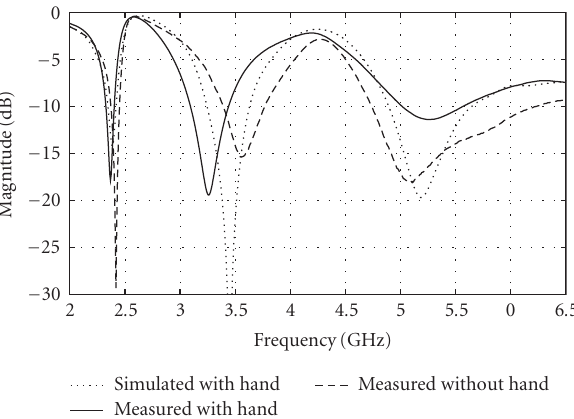
Figure 13: User’s hand e ff ect on the reflection coe ffi cient of the proposed